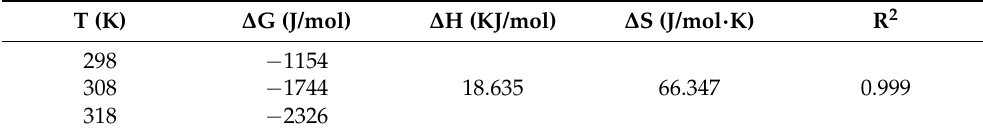
Table 1. The thermodynamic parameters for TC adsorption by CG.